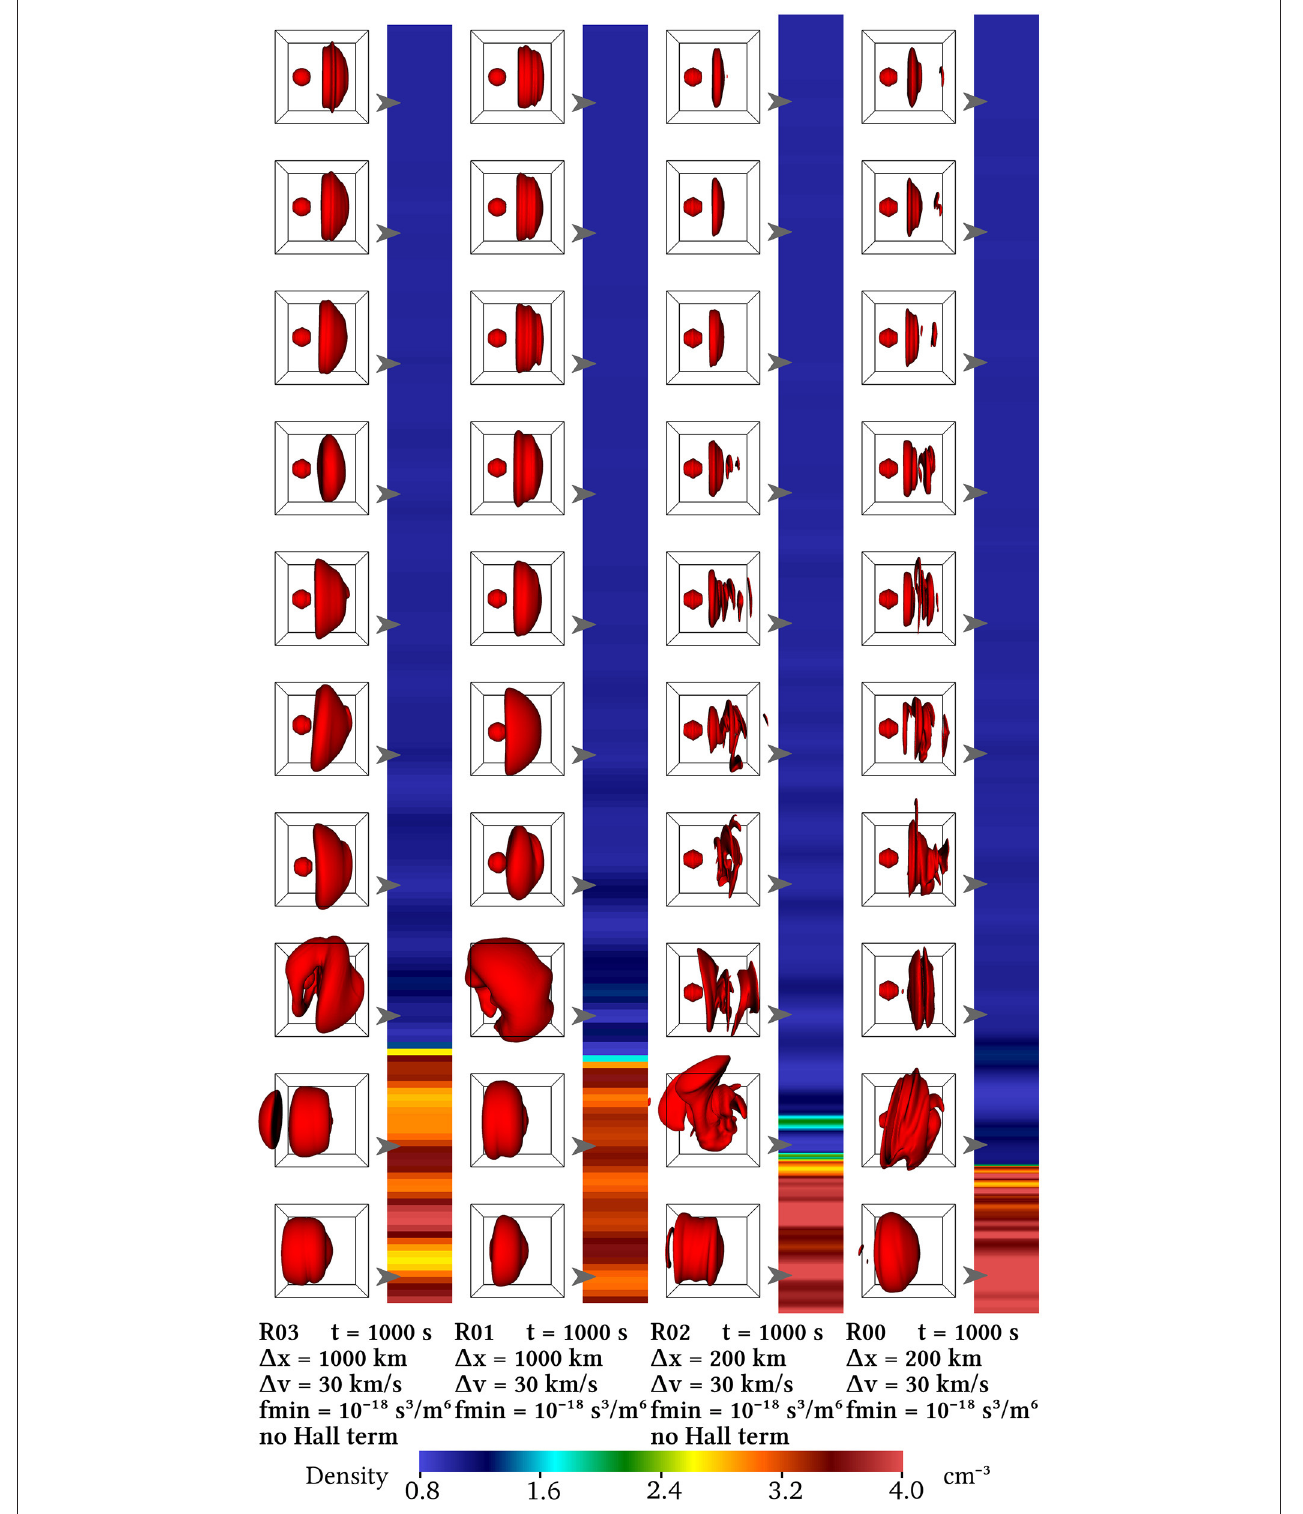
FIGURE 5 | Runs R03, R01, R02, and R00 showing the effect of the Hall term in Ohm’s law in the field solver. At these spatial resolutions, the Hall term effects are not expected to make a significant difference, as can also be seen in the corresponding Supplemental data Animation A3 and Figure 6 .